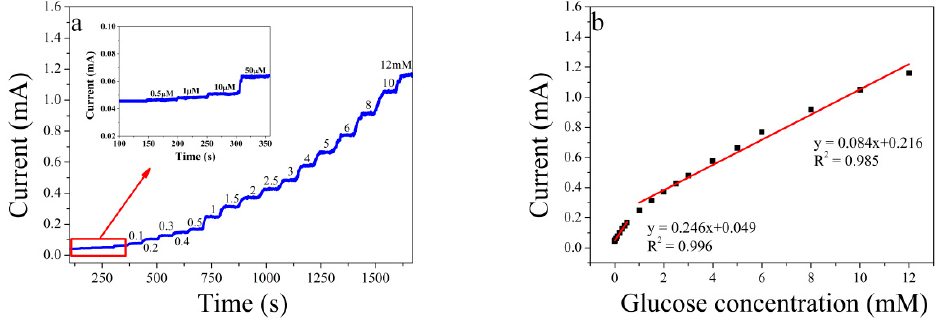
Figure 3. ( a ) Amperometric current–time ( i – t ) curves for Au foam at various glucose concentrations at 0.1 V and at intervals of 50 s, and ( b ) plot of glucose concentration vs. current.